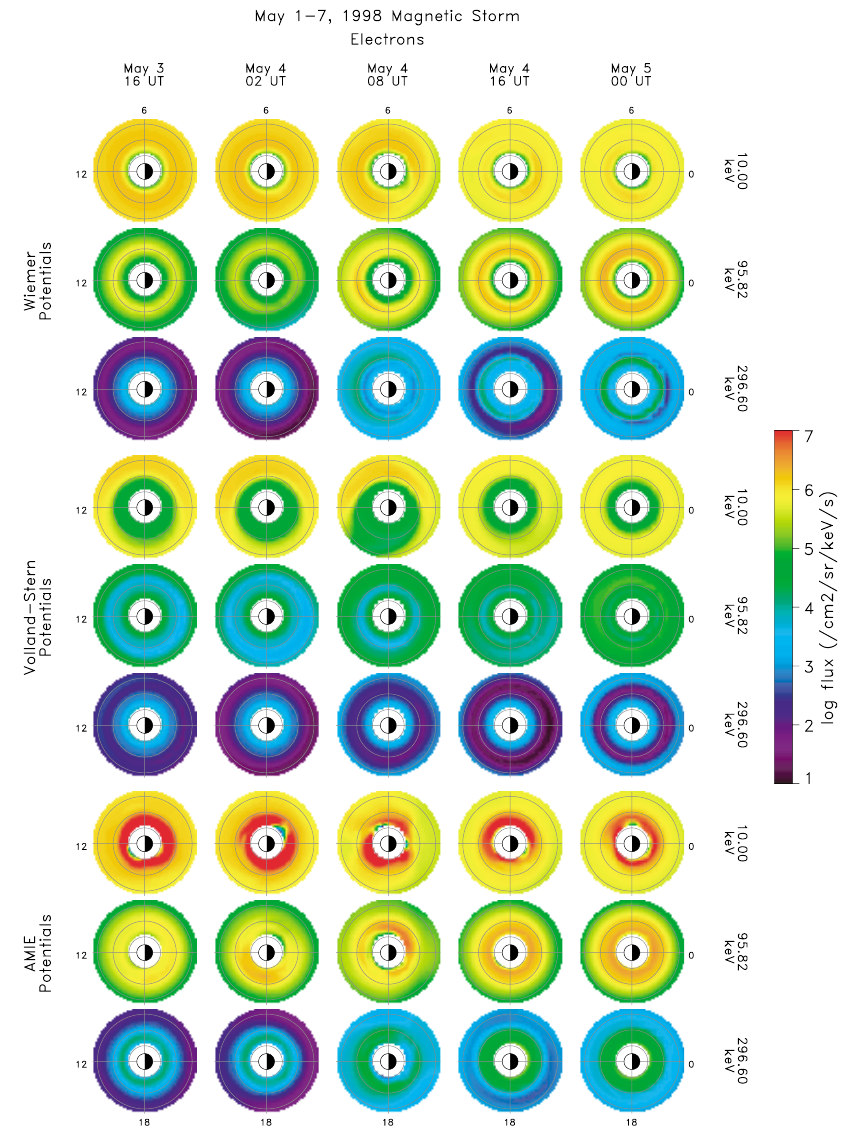
Fig. 10. Same as Fig. 9, except for electrons. Note that the selected energies are different than those chosen for the ion